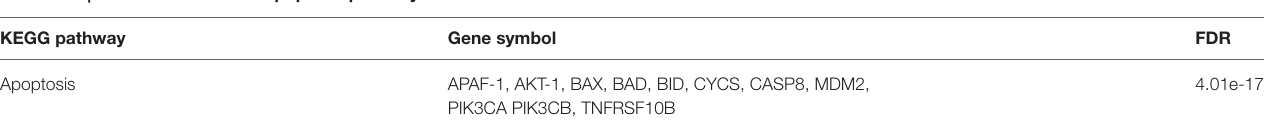
TABLE 3B | CBD modulated the apoptotic pathway in hGMSCs. KEGG